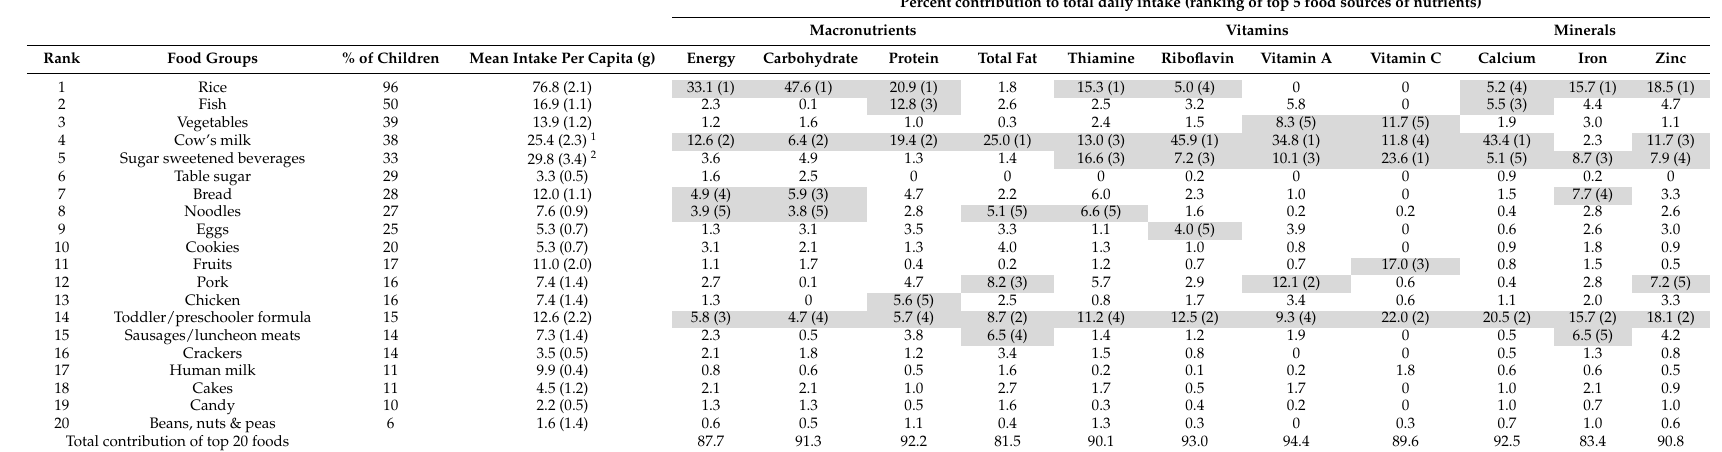
Table 8. Top-20 most consumed food groups and their contribution to energy and selected nutrient intakes among toddlers aged 24–35.9 months ( n = 727) in the